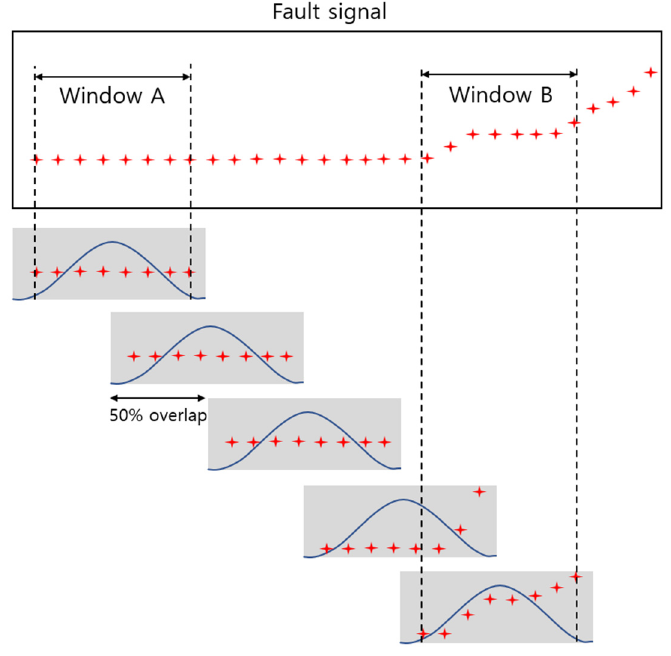
Figure 16. Definition of overlap [24].